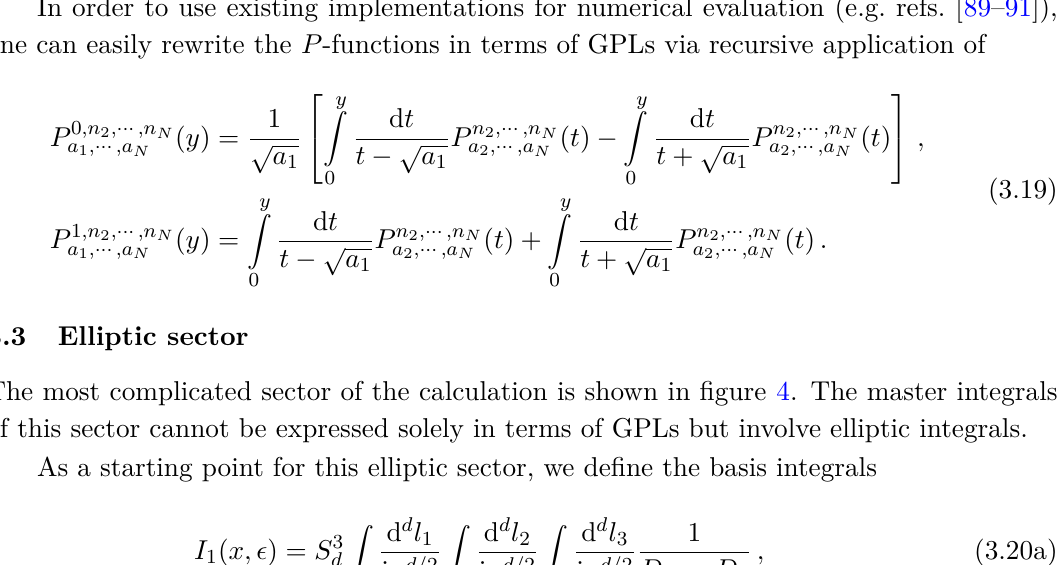
Figure 4. Elliptic sector. The notation is the same as for figure